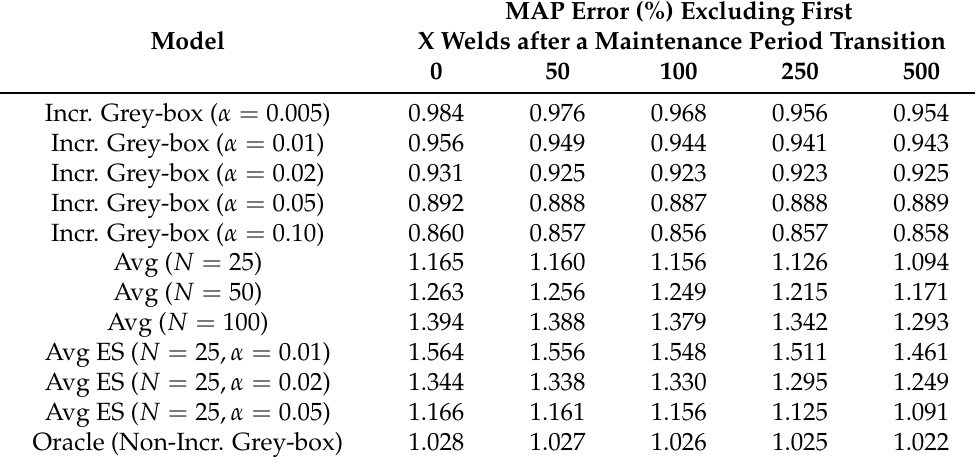
Table 3. Mean absolute percentage error of welding current prediction for all models for all welds in maintenance periods 2 and 3, excluding a number of welds that occur just after either behavioral change. All average-based models perform best when ignoring up to 500 welds after each transition, indicating they require a long time to adjust. In contrast, the physics-based models perform optimally after 50 to 250 welds. Overall, the incremental model outperforms the average-based models and even the oracle model. This shows that welding current is also affected by local temporal changes captured by the incremental model. MAP Error (%) Excluding